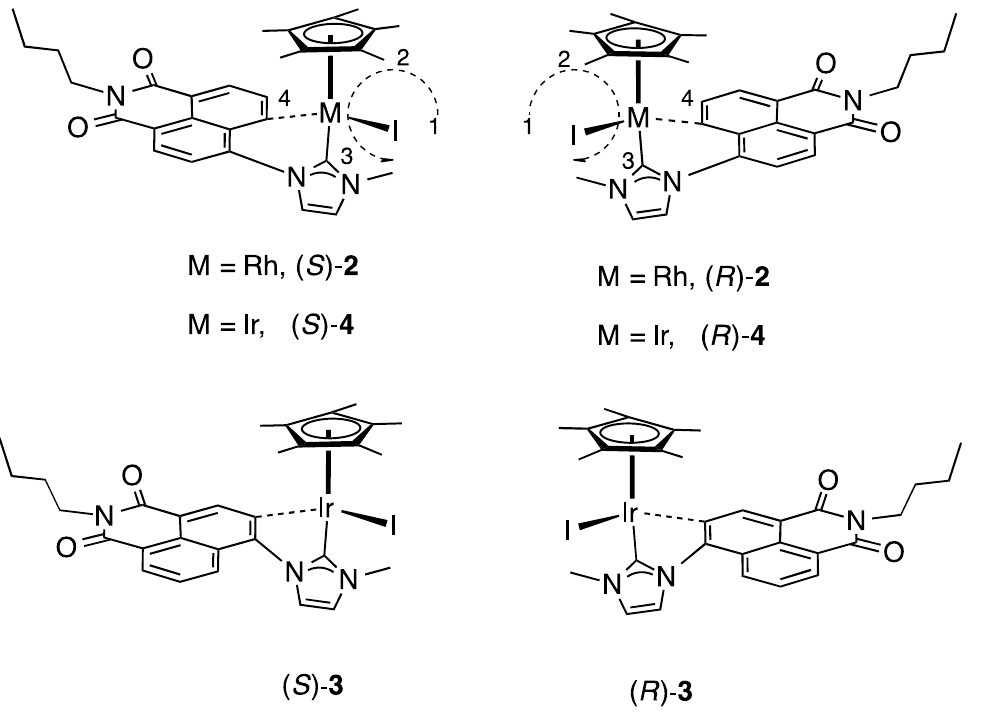
Figure 1. Optically active molecules ( S )- 2 , ( S )- 3 and ( S )- 4 /( R )- 2 , ( R )- 3 and ( R )- 4 described in this work and priority rule used (I > Cp > C-Carbene > C-arene) to assign the absolute configuration [34,35].